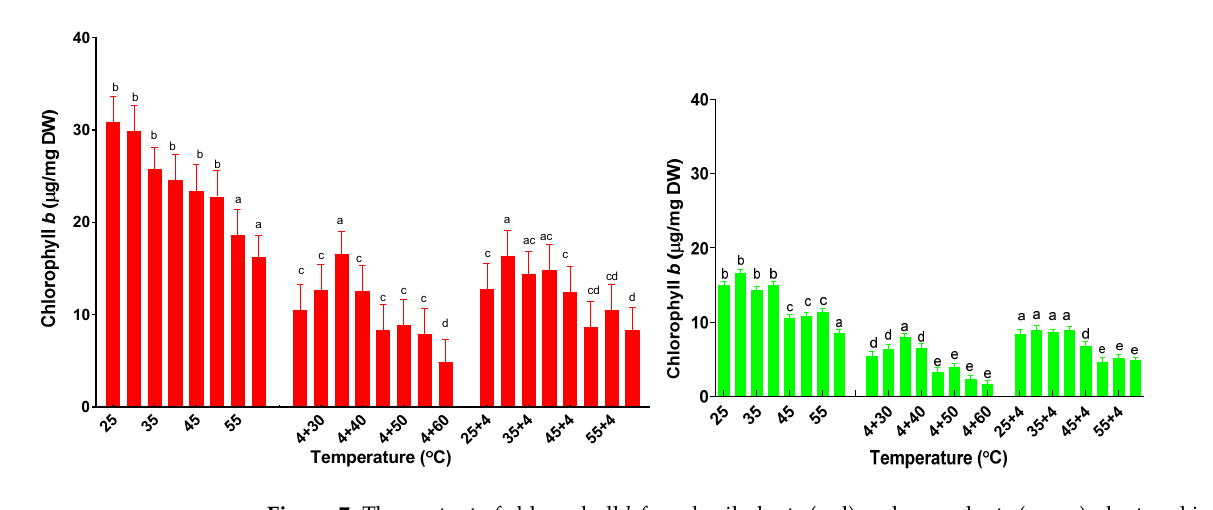
Figure 7. The content of chlorophyll b from basil plants (red) and sage plants (green) plants subjected to different temperatures. Data sharing different letters are significantly different ( p < 0.05), while data sharing the same letters are not significantly different ( p > 0.05).